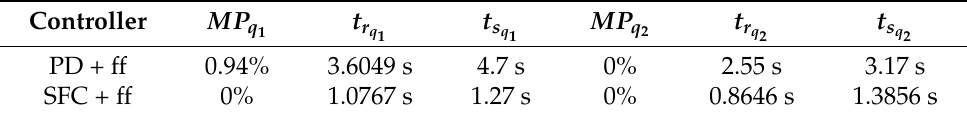
Table 10. Transient response comparative of the experimental